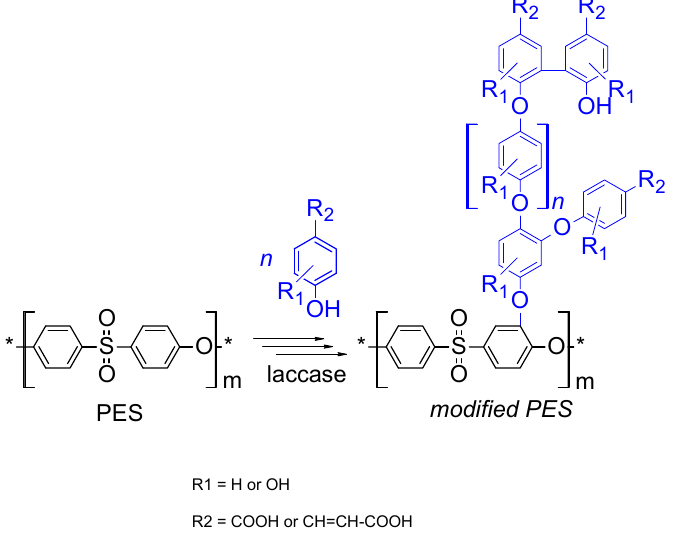
Figure 2. Tentative mechanism for the reaction of laccase-generated radicals with poly(ethersulfone) (PES), and subsequent formation of grafted brushes [50].